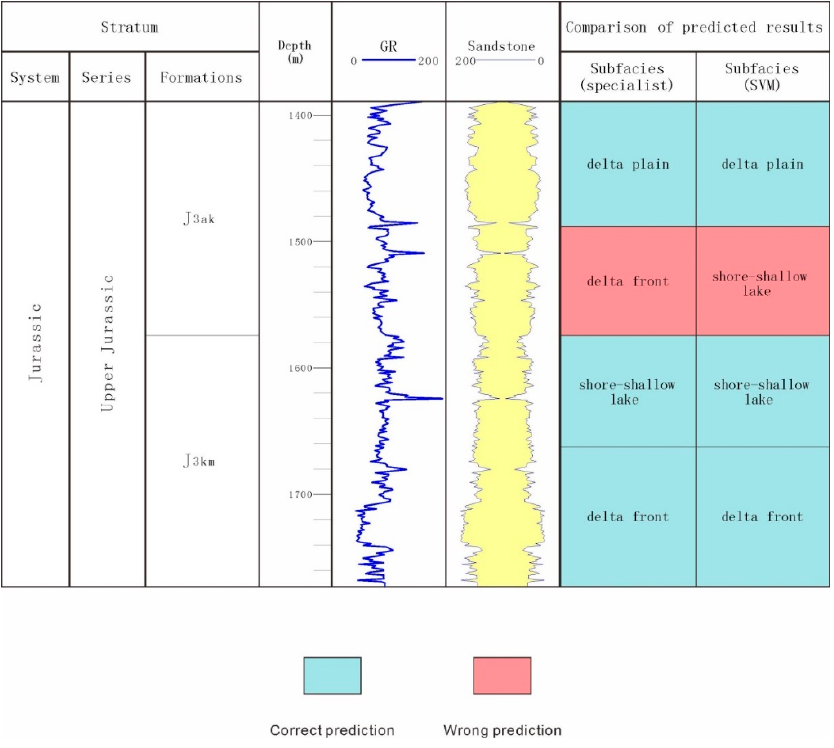
Figure 8. Comparison of the subfacies identification results by the SVM and geologists in well ARY15.